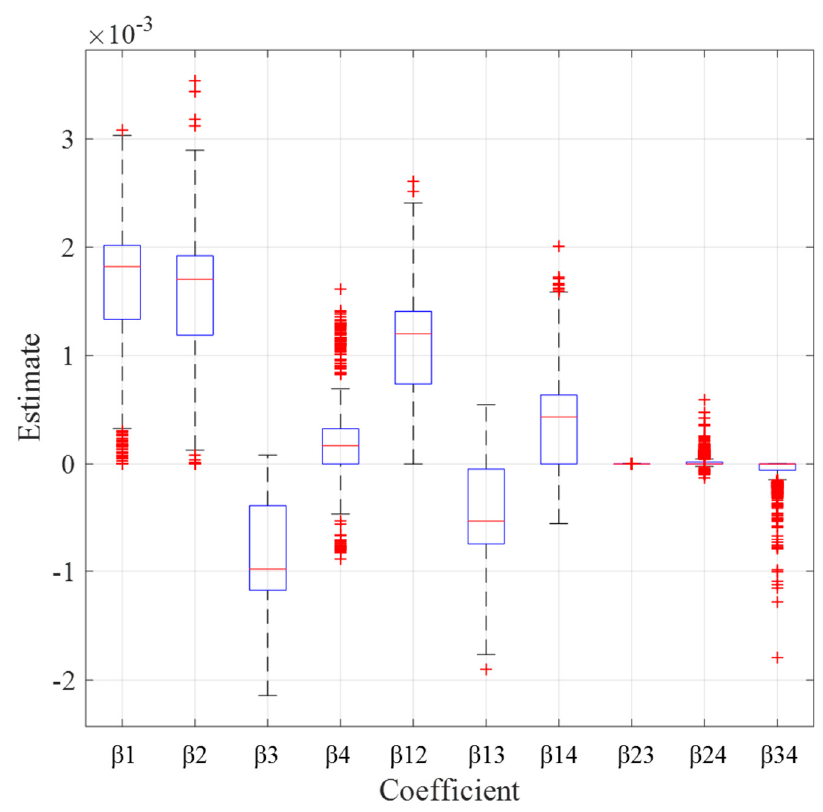
Figure 3. Box plots of (individual and interaction) effect size estimates generated from bootstrap least absolute shrinkage and selection operator (LASSO) for Manufacturer 1.